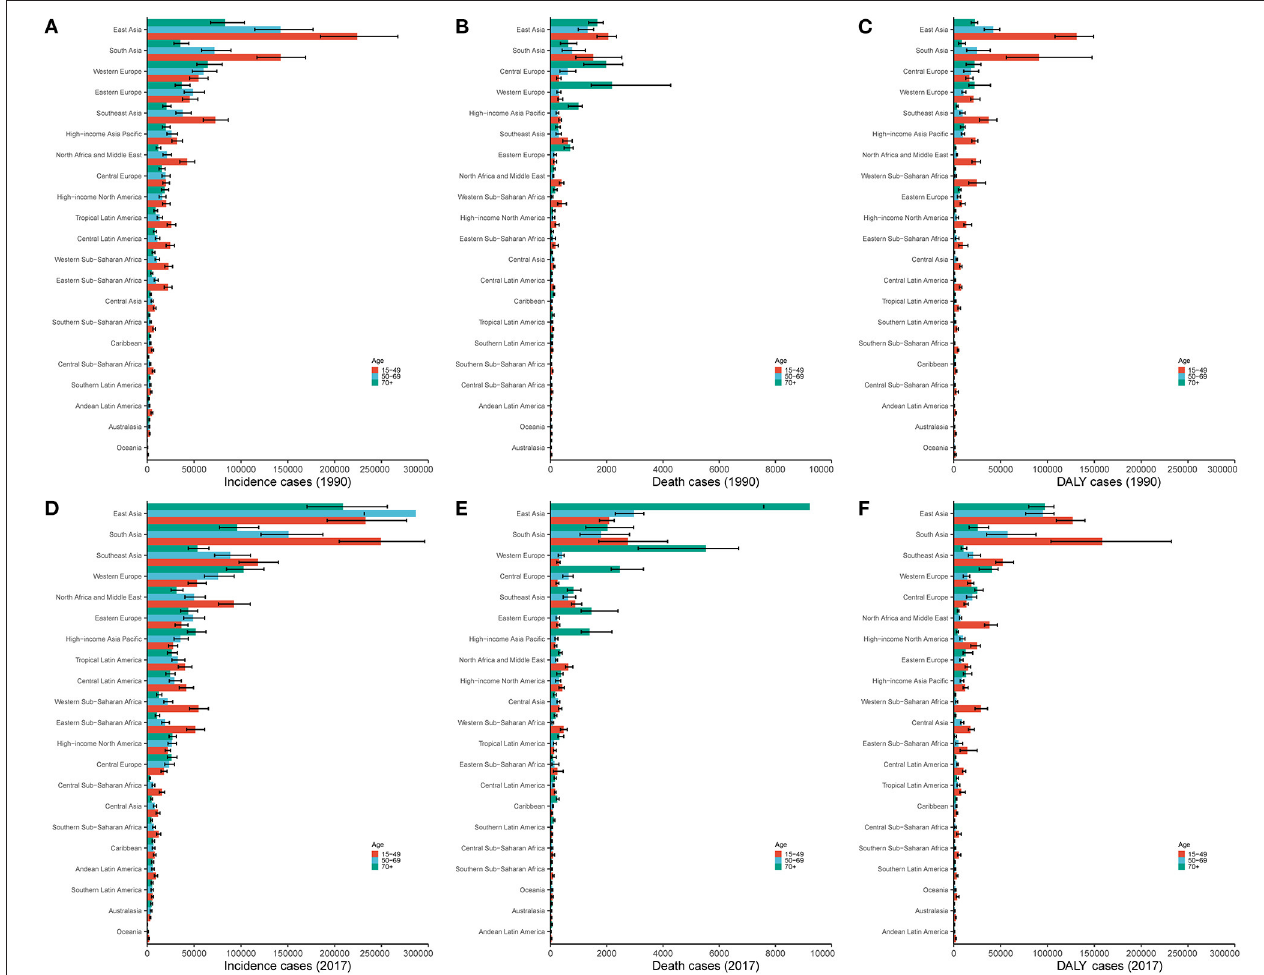
FIGURE 5 | The proportion of the three age groups (15–49, 50–69, and 70 + years) for myocarditis incidence (A,D) , deaths (B,E) , and DALYs (C,F) in 21 GBD regions between 1990 and 2017. DALY, disability-adjusted life year; GBD, Global Burden of Disease.